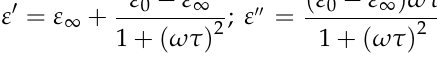
Figure 4. Measurement diagram of dielectric properties (23.5 °C at 1 atm). Figure 4 shows that the real part of the dielectric constant decreases with increasing frequency and increases with increasing moisture content. Regarding the imaginary part of the dielectric constant, because insulating oil has a low dielectric loss due to its stability, the imaginary part of the dielectric constant of the pure oil is close to zero. The dielectric loss increases with increasing moisture content, and its imaginary part deviates from zero. ε 0 , ε ∞ and τ of the pure oil can be obtained by numerically fitting the experimental values in Figure 4 to the formula for the dielectric constant given in Equation (20) [27].